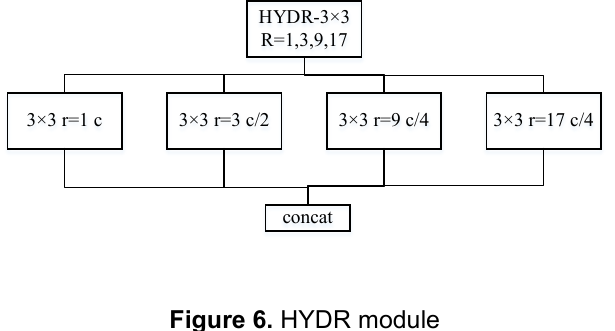
Figure 6. HYDR module